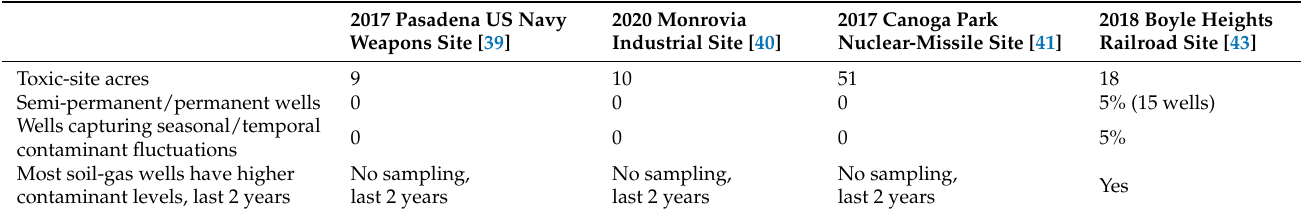
Table 5. Examples of RepQ8–9 in CBRE/TCC soil-gas assessments 2017–2020.